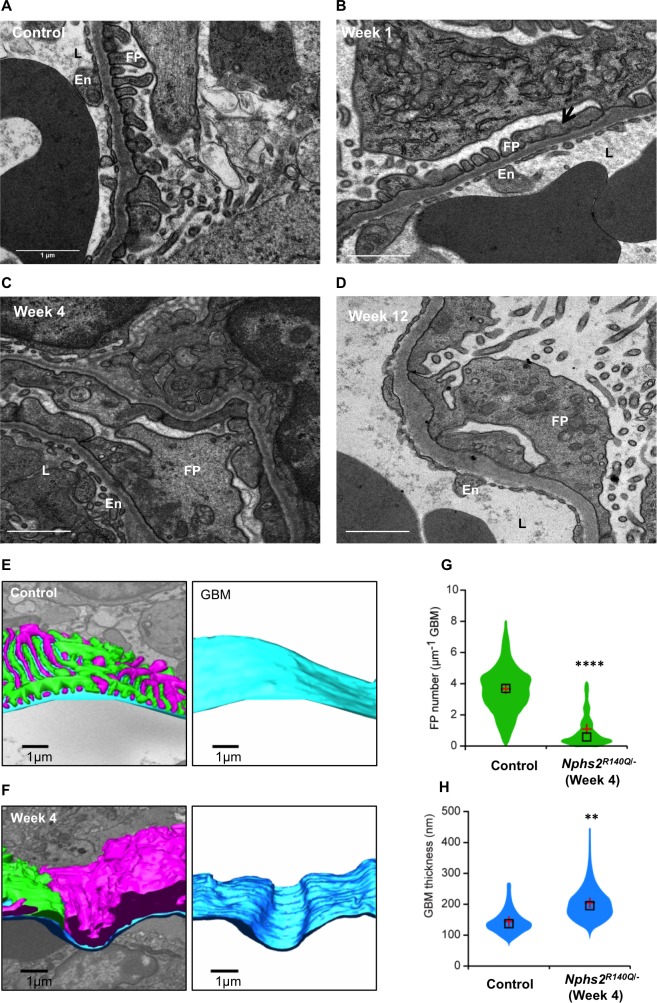
Podocyte foot process effacement in Nphs2R140Q/- mice.(A) Ultrastructural studies showed regular foot processes (FP) in healthy control animals on the opposite side of endothelial cells (En) lining the capillary lumen (L). (B) Irregularly shaped or fused FPs in Nphs2R140Q/- mice one week after induction (arrow). (C and D) Progression of focal changes to global fusion of FPs in Nphs2R140Q/- animals over time (Magnification, X10000). 3D modelling of glomerular structure showed no GBM denudation in Nphs2R140Q/- animal (F) compared to controls (E). Blue colour represents GBM, pink and green represent FPs of adjacent podocytes. Severely affected FP number and organization in Nphs2R140Q/- animals (G). GBM thickening in Nphs2R140Q/- animals (H) (G and H: analysis is based on 3 animals per group). ** p<0.01, **** p<0.0001.